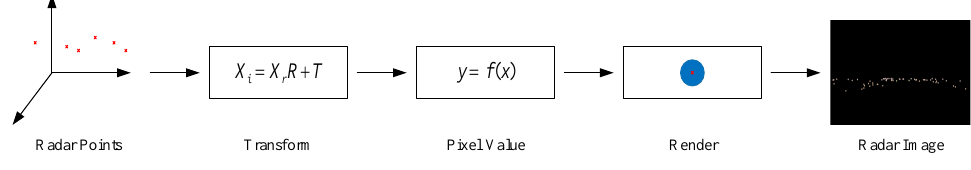
Figure 4. The radar image generation model.